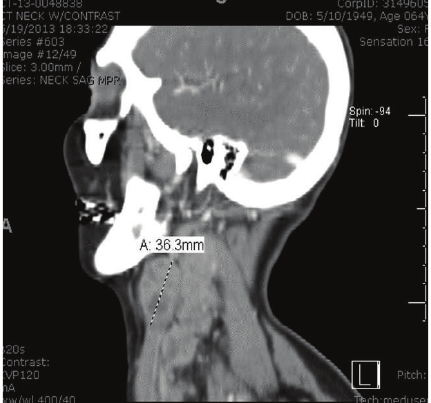
Figure 1: CT of the neck indicating the largest lymph node on left measuring 36.3 mm.